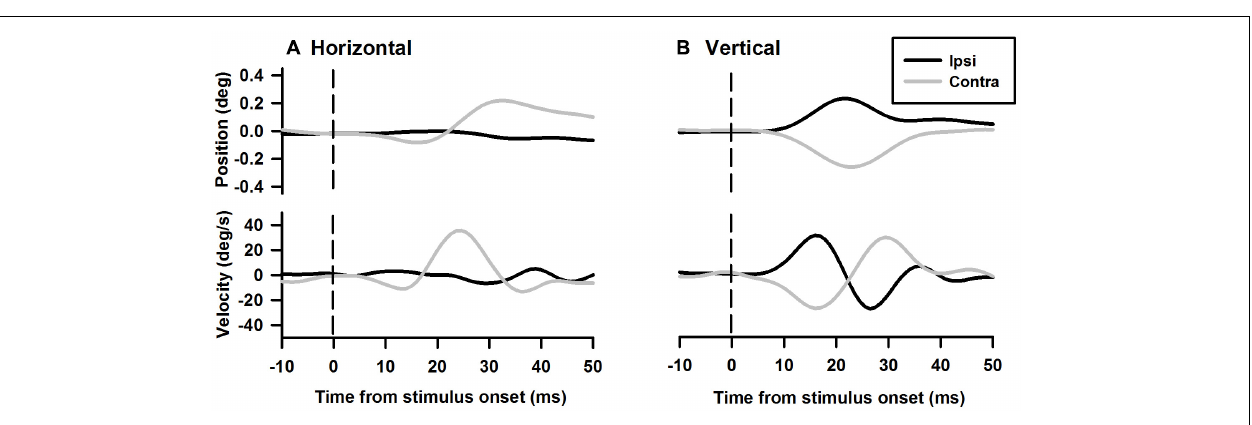
vertical eye movements, peak velocities of 1,500 Hz tone-evoked eye movements were plotted as a function of intensity for ipsilateral (black lines) and contralateral (gray lines) stimulation ( Figure 12 ). While sound-evoked vertical eye movements increased with tone intensity for either ipsilateral (slope: 1.47 deg/s/dB, R 2 = 0.99) or contralateral (slope: -1.38 deg/s/dB, R 2 = 0.93) stimulation, sound-evoked horizontal eye movements increased with tone intensity only for contralateral (slope: -0.5 deg/s/dB, R 2 = 0.93) stimulation, but not for ipsilateral (slope: 0.07 deg/s/dB, R 2 = 0.15) stimulation. Figure 13